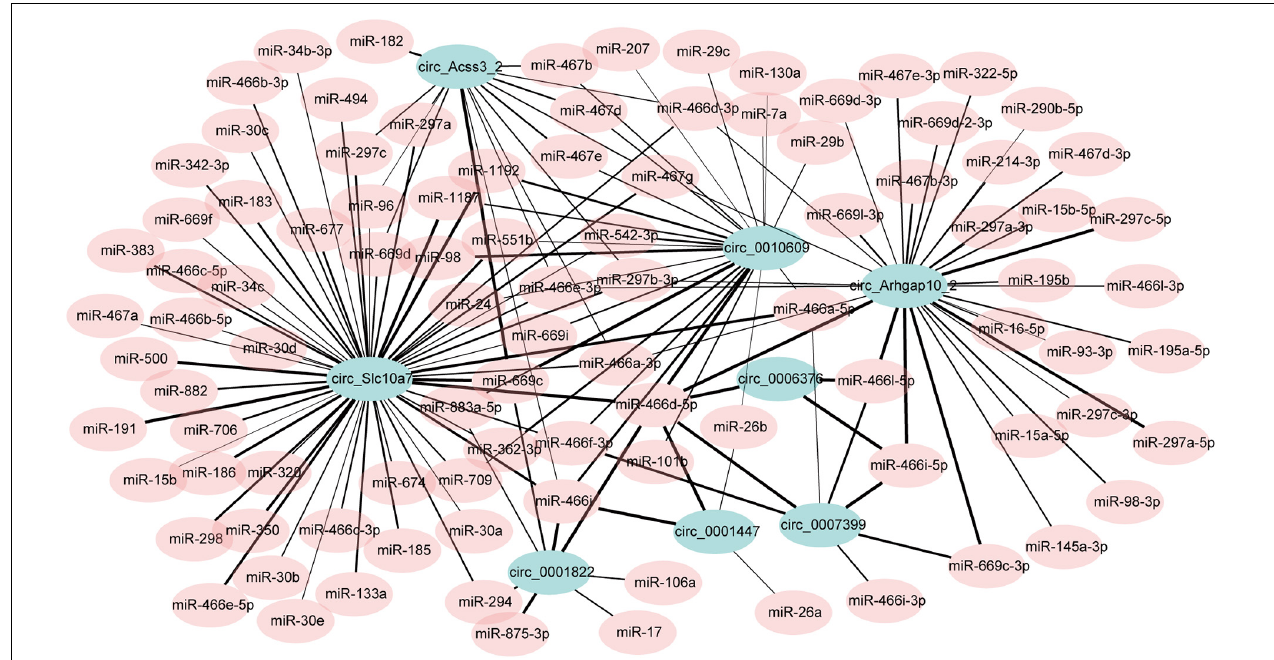
FIGURE 5 | The potential circRNA-miRNA interaction network. The width of the edge indicates the prediction score (range from 85 to